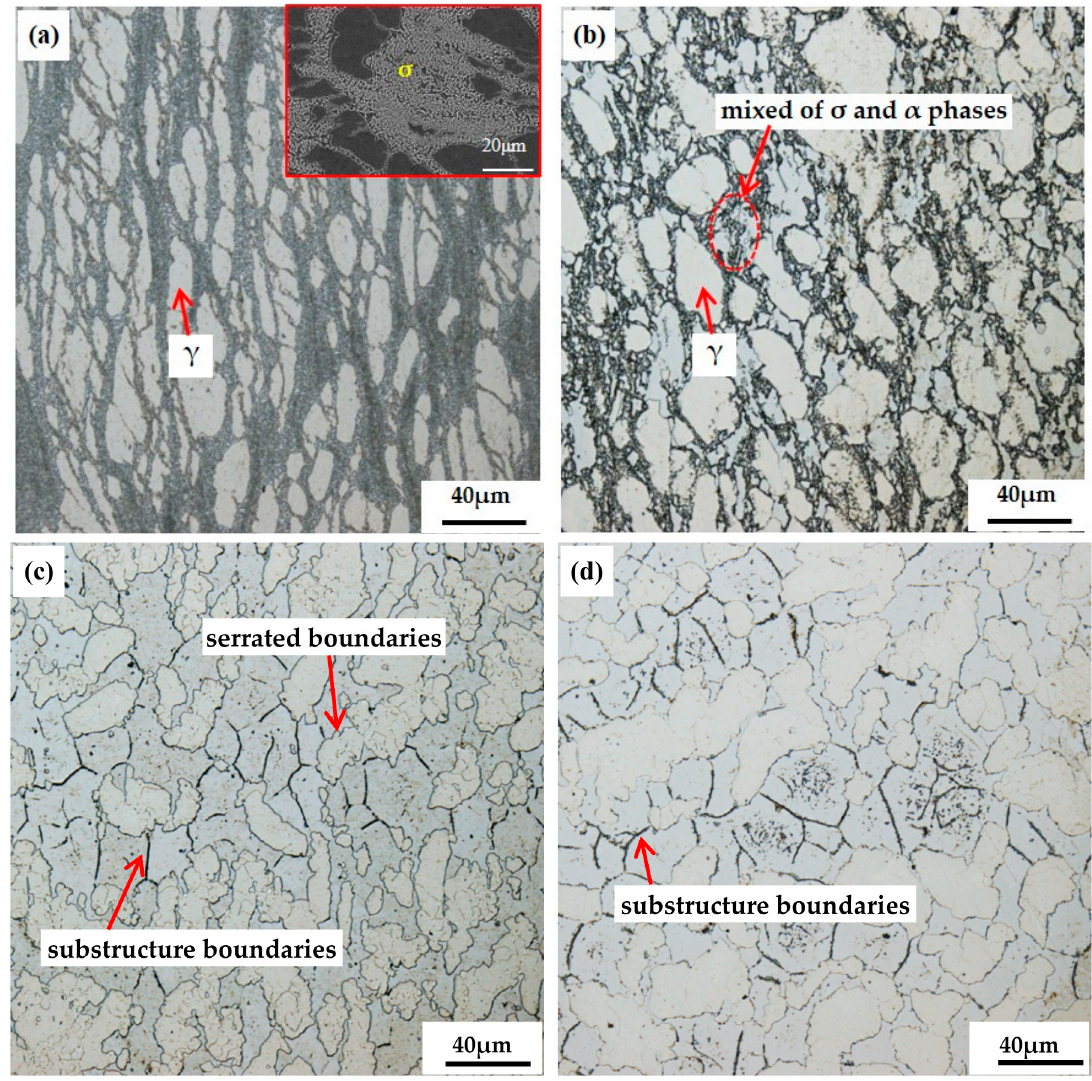
Figure 3. Microstructures of 2707 HDSS deformed at 0.01 s − 1 and different temperatures: ( a ) 950 °C; ( b ) 1050 °C; ( c ) 1150 °C; ( d ) 1250 °C.